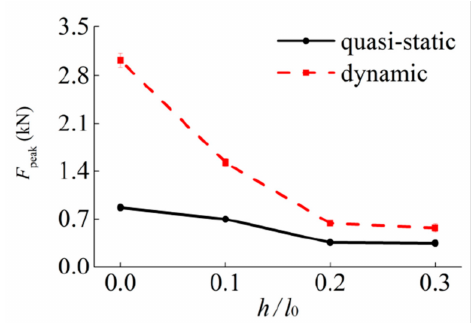
Figure 14. The initial peak force under quasi-static and dynamic compressive loading.